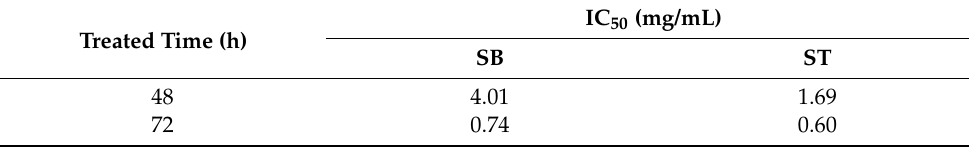
Figure 2. Effects of SB and ST treatments on cell proliferation of HSC-3 for 48 h ( A ), 72 h ( B ) and NHOK for 72 h ( C ) at various concentrations. Bars represent standard deviations from triplicate determinations. Data, mean ± SD (n = 3). * p < 0.05 and ** p < 0.01 against control. Table 1. IC 50 values of SB and ST on HSC-3 at 48 and 72